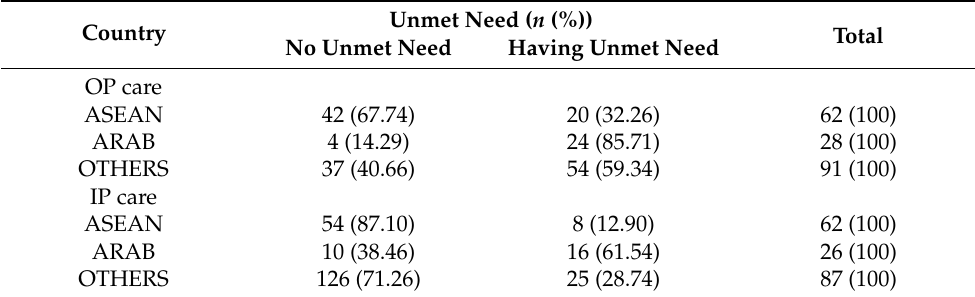
Table 2. Unmet need prevalence of Out-patient (OP) and In-patient (IP) care.